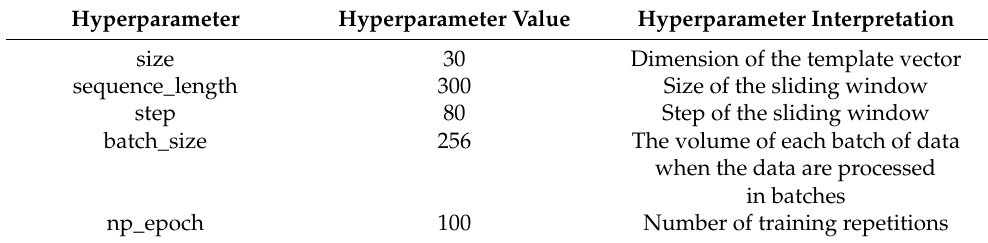
Table 8. Final hyperparameter configuration table of the model.